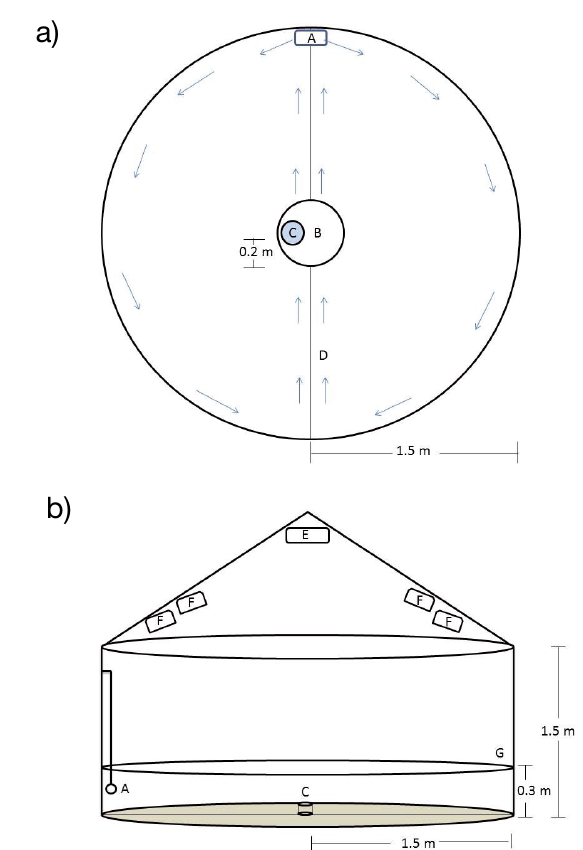
Fig. 1. Set-up of the tanks used for the foraging experiment: (a) aerial view and (b) cross-section. Water flowed from a T- shaped inlet (A) around the tank as shown by the arrows. The tank was divided in half with a lead line (D) along the water flow in the centre. Water drained through a 76.2 mm diameter PVC drain pipe (C) that was plumbed through a 0.2 m radius circular Coroplast TM cover (B) where no sedi- ment was placed. A camera (E) was mounted at the top of the tank, and a red and a white light (F) was placed above each side of the tank. Red light was used to film the animals during the night. Water depth in the tank was 0.3 m